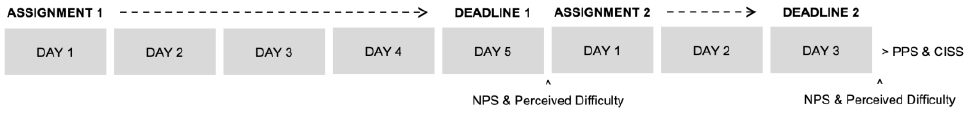
Figure 1. Overview of the study procedure: Participants were asked to summarize two academic articles in two different sessions. The deadline for the first session was set to 5 days, whereas that for the second session was set to 3 days. The NPS and a set of items for assessing the perceived difficulty of the task were administered after each session. The PPS and the CISS questionnaires were administered at the end of the study.